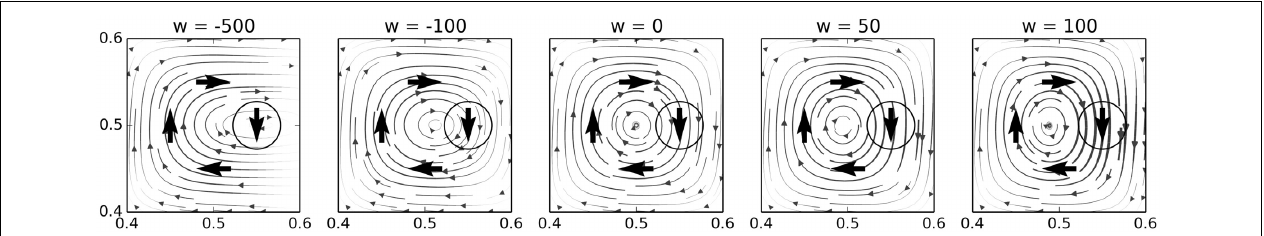
2-motor, 0-sensor IDSM with four activated nodes, each given a weight ( N w ) of 0, except for the circled node on the right, which has the weight indicated at the top of each